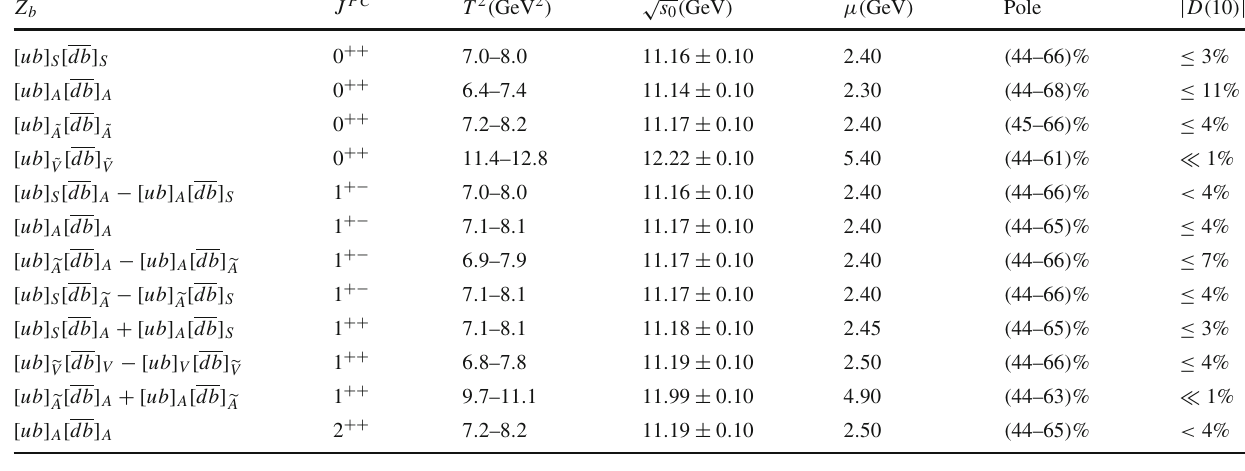
Table 3 The masses and pole residues of the ground state hidden-bottom tetraquark states